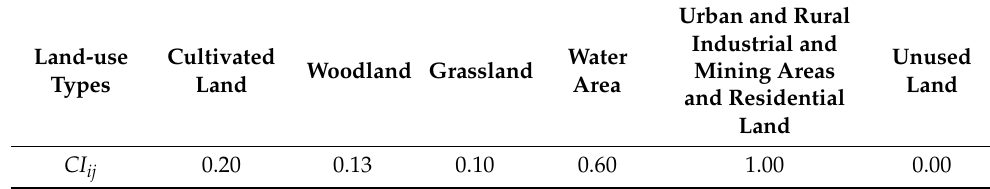
Table 4. Equivalent conversion coefficient of construction land for different land-use